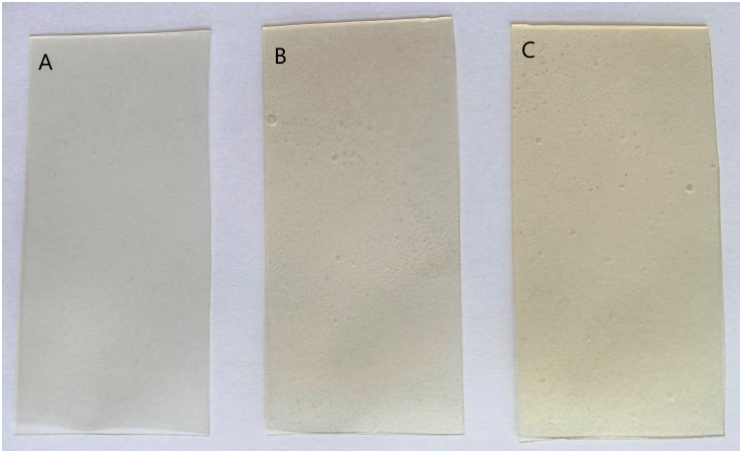
Figure 1. Bioplastic generated from potato starch and different gelatines. ( A ) piscine gelatine, ( B ) porcine gelatine, and ( C ) bovine gelatine.